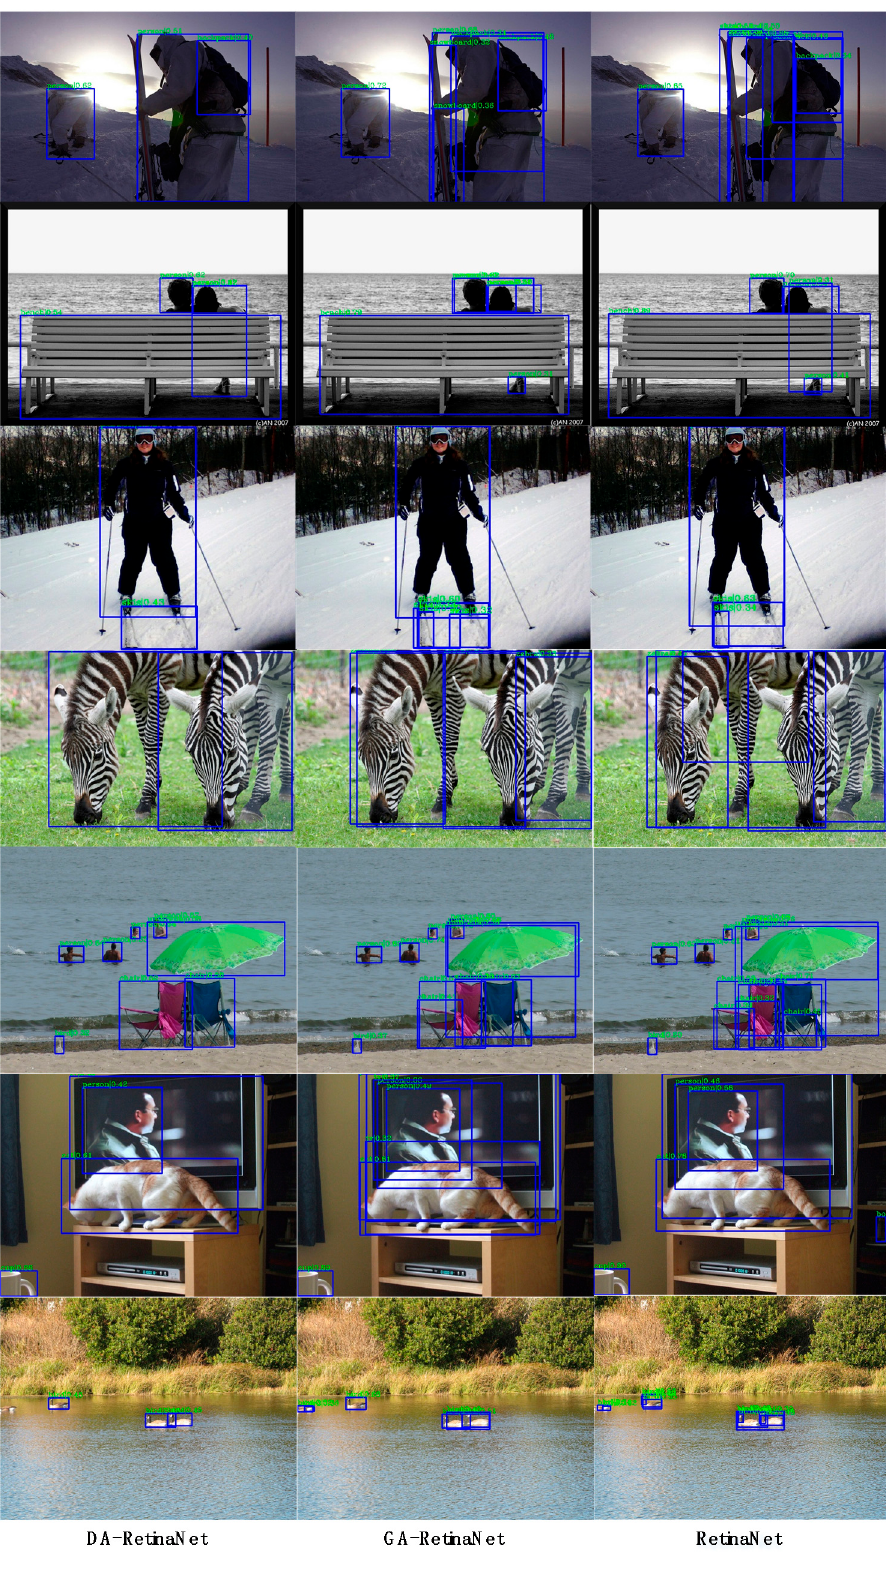
Figure 8. Comparison of the detection results of the DA-RetinaNet, GA-RetinaNet and RetinaNet.